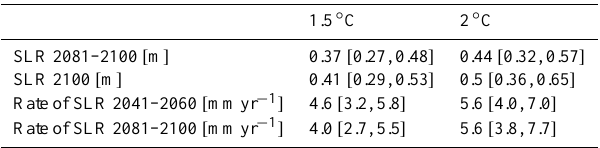
Table 2. Projections for sea-level rise above year 2000 levels for two illustrative 1.5 ◦ C and 2 ◦ C scenarios (see Fig. 13). Square brackets give the likely (66%)